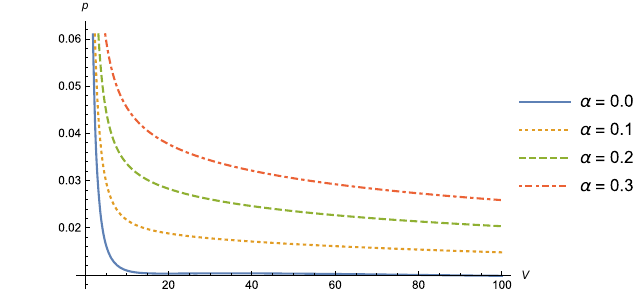
Fig. 7 Graphs p x V for T = 0 . 1, a = 0 . 1 and different values of α